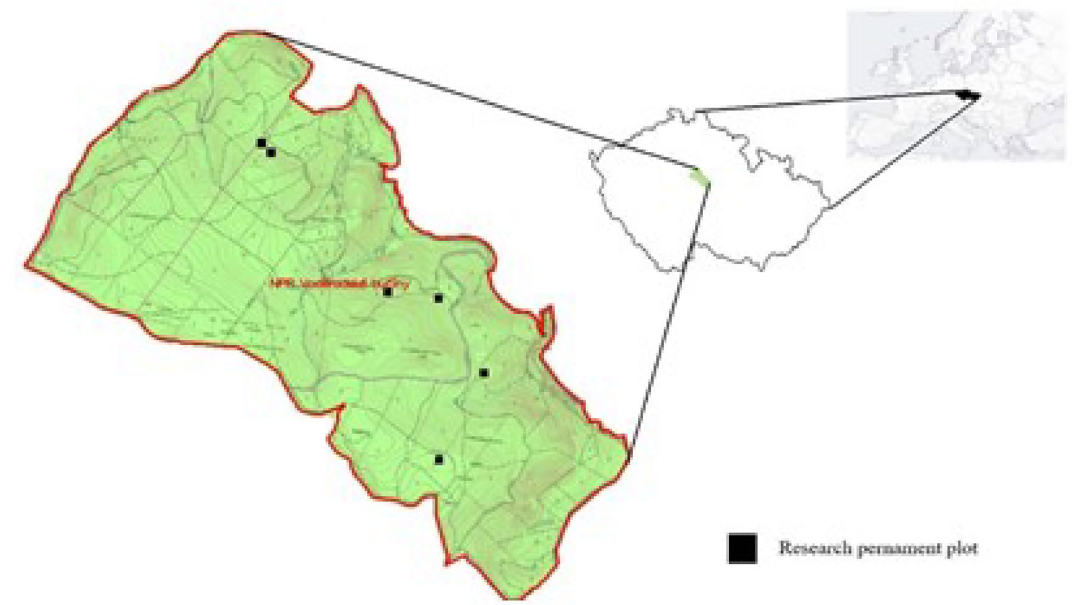
Figure 1. Location of the study area and adjustment of permanent plots in the study area. The map was created in the Paint 3D application (Microsoft,